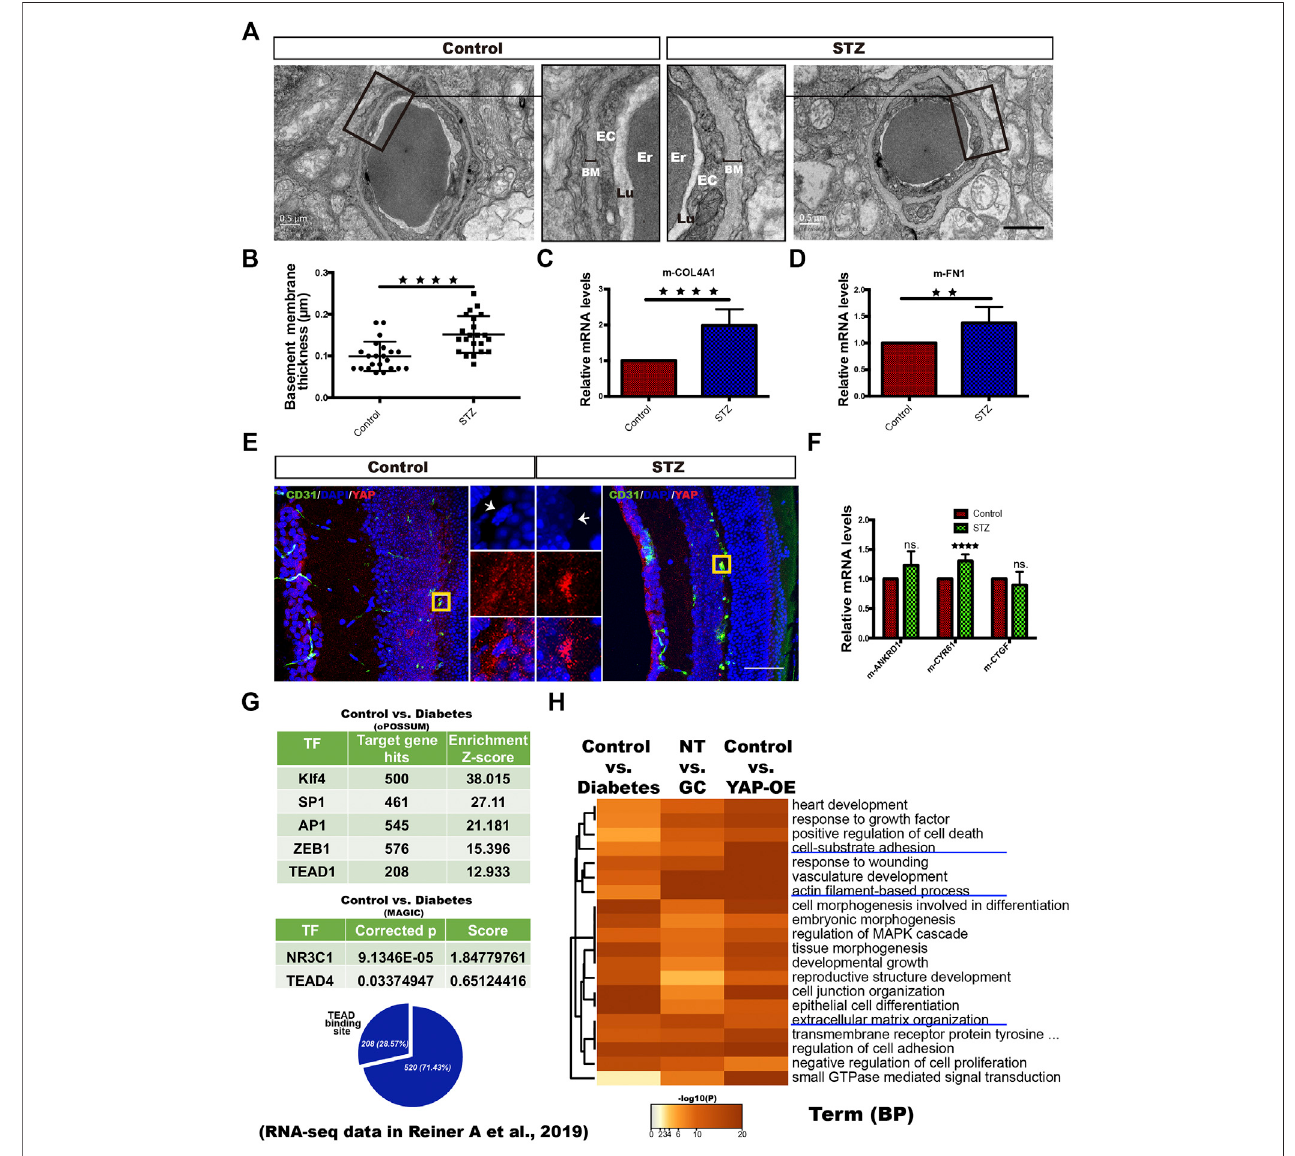
FIGURE 8| YAP activation in vascular ECs ofdiabeticpatientsand STZ-induced diabetic mice. (A) : TEM images ofretinal capillaries ofSTZ-induced diabetic mice and control mice. The magni fi ed views show thickening of the BM in STZ-induced diabetic mice. EC endothelial cell, Er erythrocyte, Lu lumen. Scale bars, 1 μ m. (B) : Basementmembrane thicknessofretinalcapillariesofSTZ-induceddiabeticmiceandcontrolmice. (CandD) :Real-timeqPCRanalysisofretinaltissuefromthecontrol and STZ-induced diabetic mice. The mRNA levels of FN1/COL4A1 (ECM components) were calculated. (E) : CD31/DAPI/YAP immuno fl uorescence staining of retinal sections from the control and STZ-induced diabetic mice. Scale bars, 50 μ m. (F) : Real-time qPCR analysis of retinal tissue from the control and STZ-induced diabetic mice. The mRNA levels of ANKRD1/CYR61/CTGF (targets of YAP) were calculated. (G) : Selected factors found in the TF binding site enrichment analysis of DEGs from the control vs. diabetes comparisons. The analysis was performed through two methods. oPOSSUM-3 is a web-accessible software program. The MAGIC algorithm was used for the analysis in Python. The proportion of signi fi cantly differentially regulated genes in the DEGs with predicted TEAD binding sites in promoter regions. Samples from four patients with T2DM (diabetes) and six nondiabetic controls (control) were included in the analysis based on the RNA-seq data of dermal vascularECsinthepublishedliterature (Reiner Aetal.,2019;GEOaccessionnumber: GSE92724). (H) :Dendrogram oftheenriched GOBPterms acrossthesigni fi cant DEGs from the diabetes vs. control, NT vs. GC and YAP-OE vs. control comparisons. The heatmap cells are colored by their p values. The error bars represent the mean ± SD (B,C,D,E) . The experiment was biologically repeated three times (A and E) , nine times (C and D) and six times (F) . ** p < 0.01; **** p < 0.0001; ns., not signi fi cant Student ’ s two-tailed paired t-test (C,D,F) or Student ’ s two-tailed unpaired t-test (B) . STZ streptozotocin, GO Gene Ontology, TF transcription factor, DEGs differentially expressed genes, BP biological process.